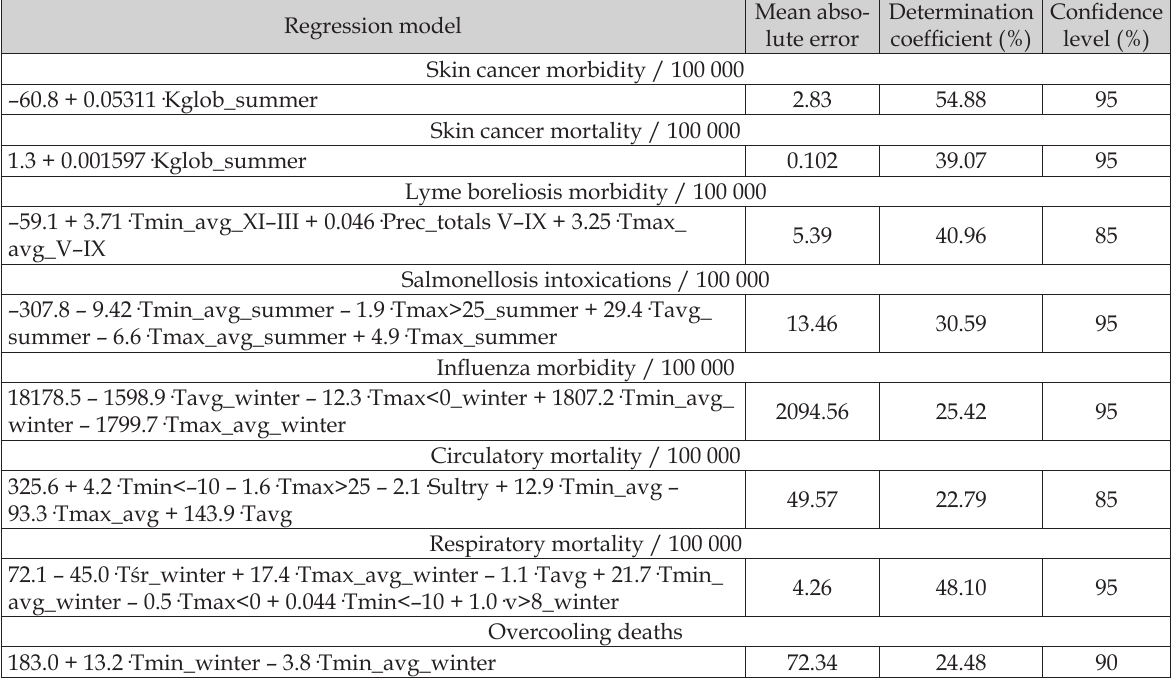
Table 2. Regression models of climate related mortality and morbidity. Regression